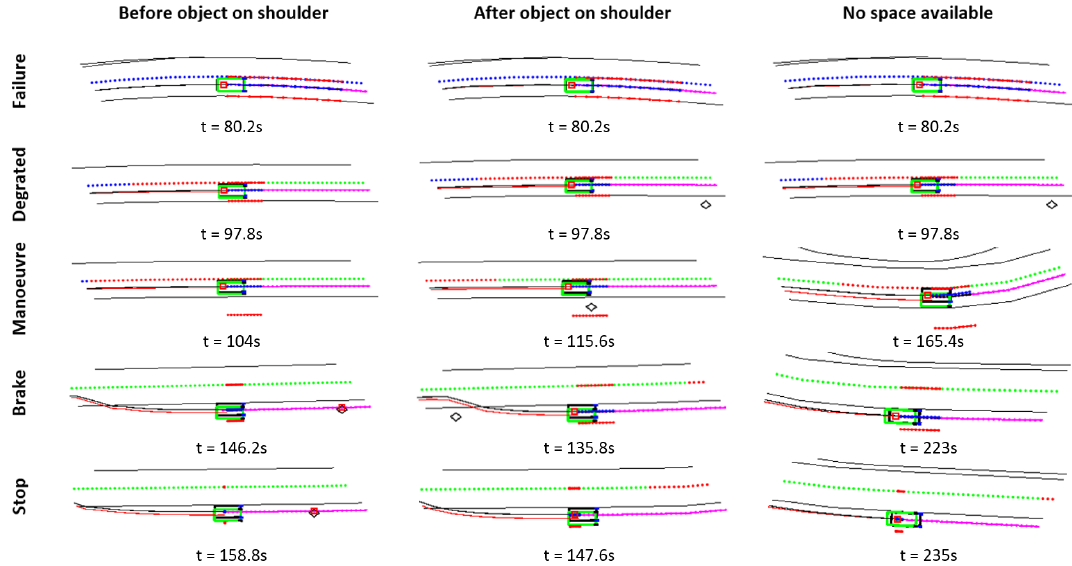
Figure 10. DDT fall-back strategy under different use